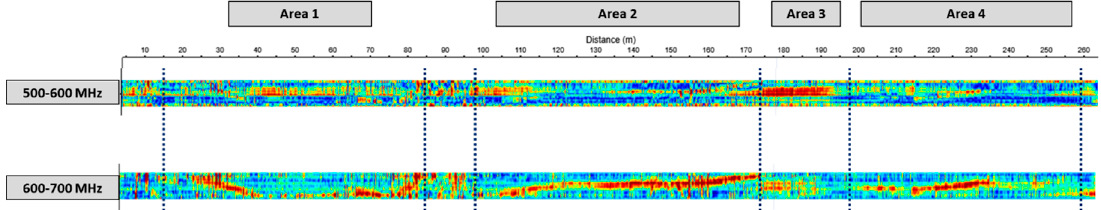
Figure 10. Appearance of the structured morphology of Area 1, Area 2, and Area 4.